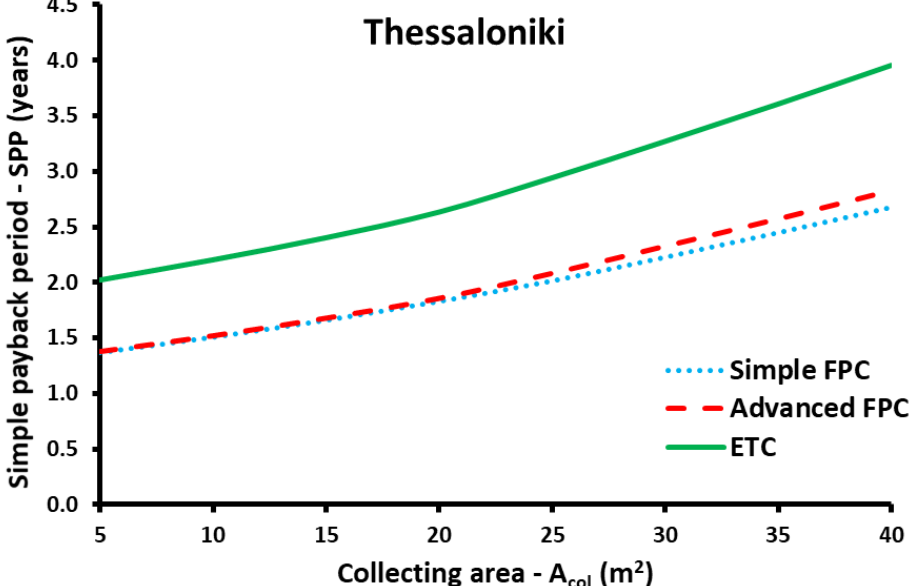
Figure 26. Simple payback period for different collecting areas and collector types for Thessaloniki.